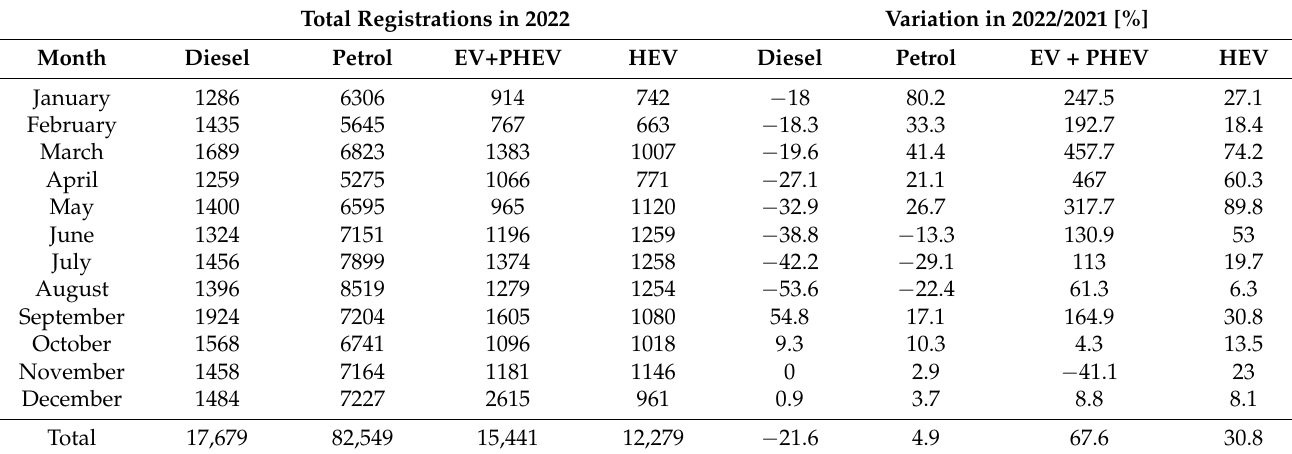
Table 1. The number of registered vehicles in Romania in 2022.